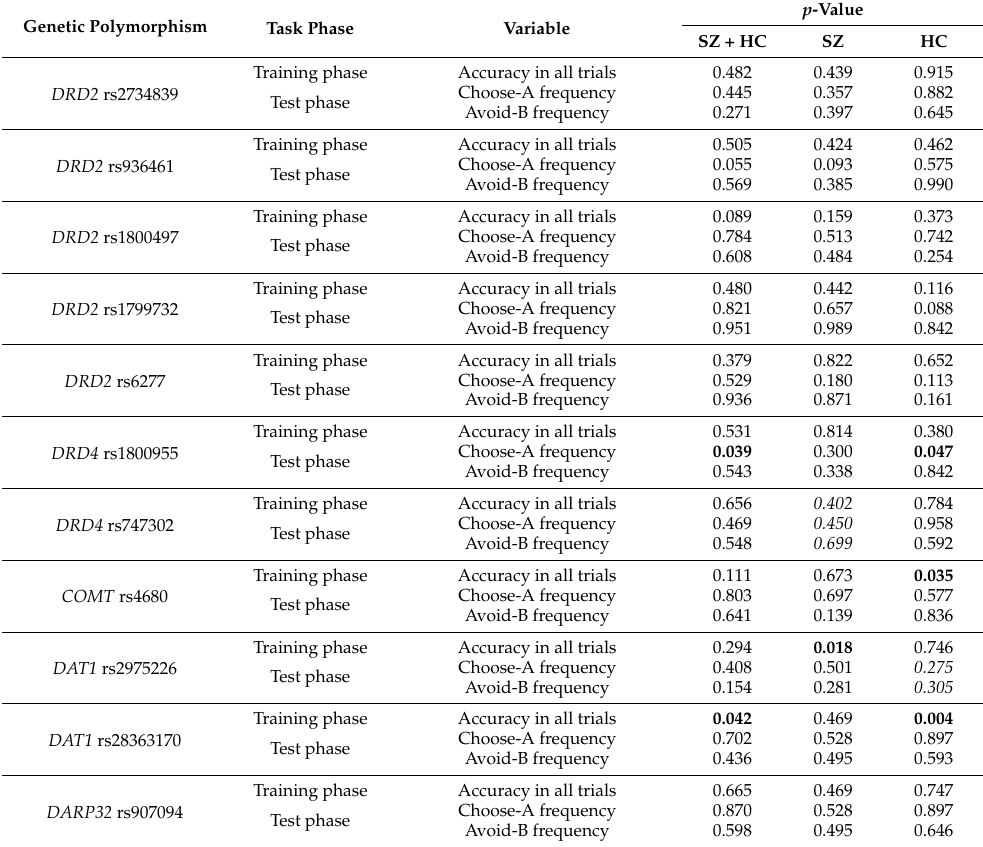
Table 3. Association between genetic polymorphisms and acquisition and test performance on PST in the whole group and with respect to SZ patients and HC